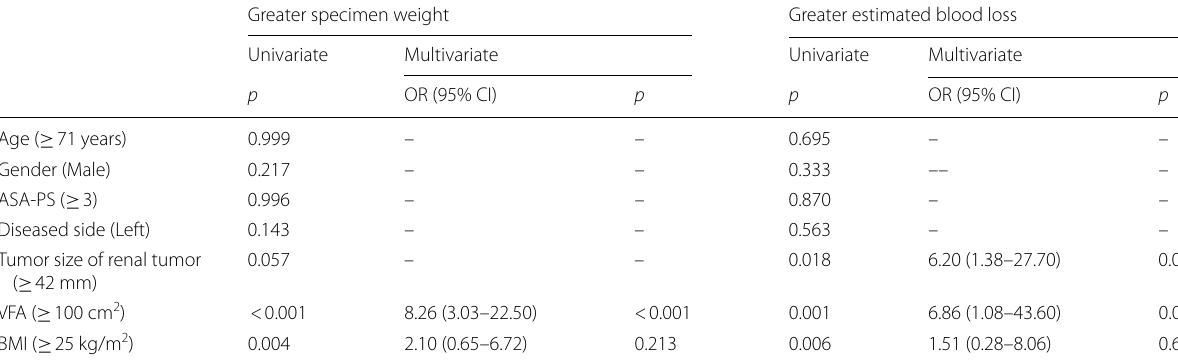
ASA-PS American Society of Anesthesiologist-performance status, BMI body mass index, VFA visceral fat area, OR odds ratio, CI confidence